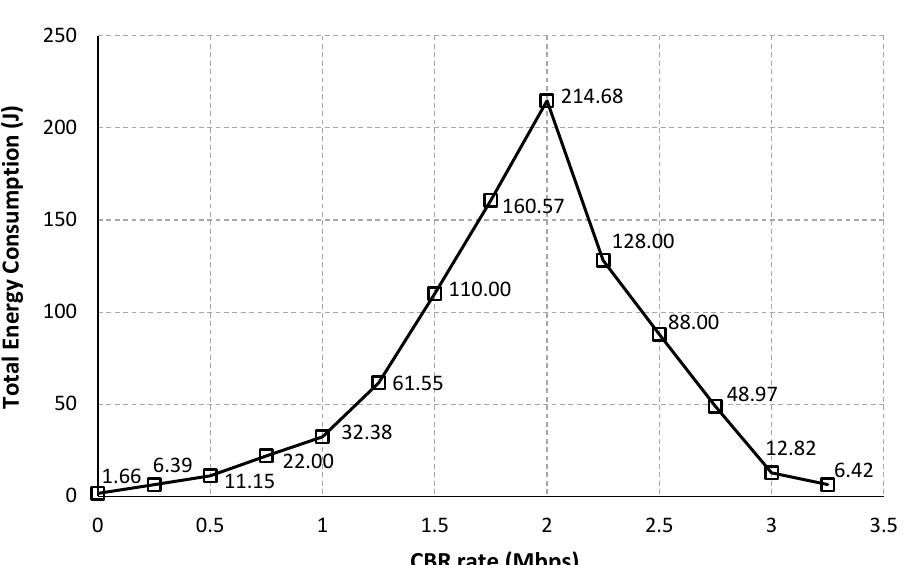
Figure 6. Total energy consumption vs . CBR